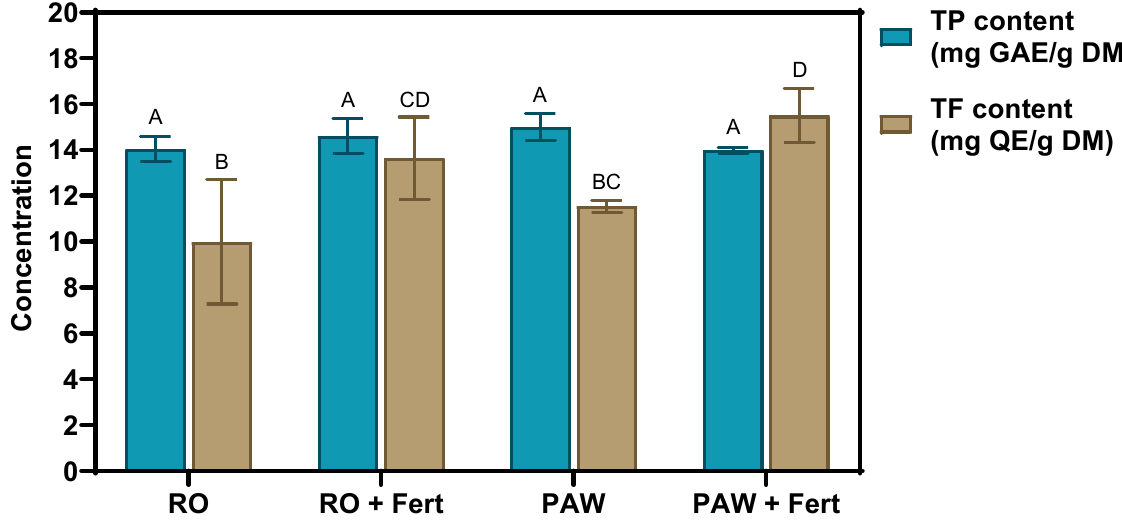
Figure 6. TP content and TF content of water spinach grown under different treatments. PAW: plasma-activated water; RO: reverse osmosis water; Fert: fertilizer. Different uppercase letters indicate the significant difference between treatment.